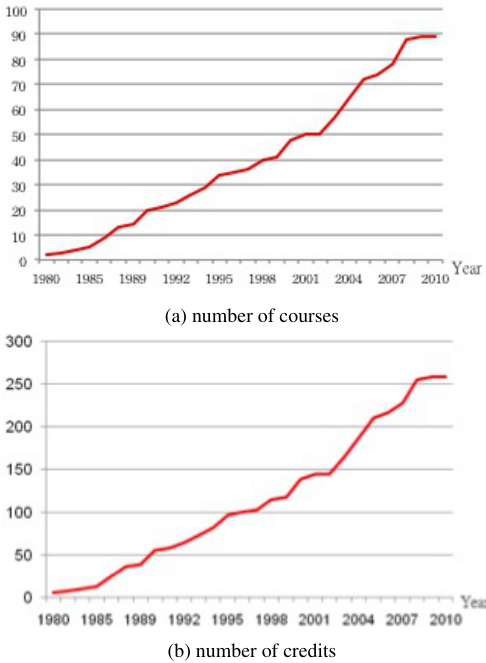
Figure 4: Number of postgraduate courses and